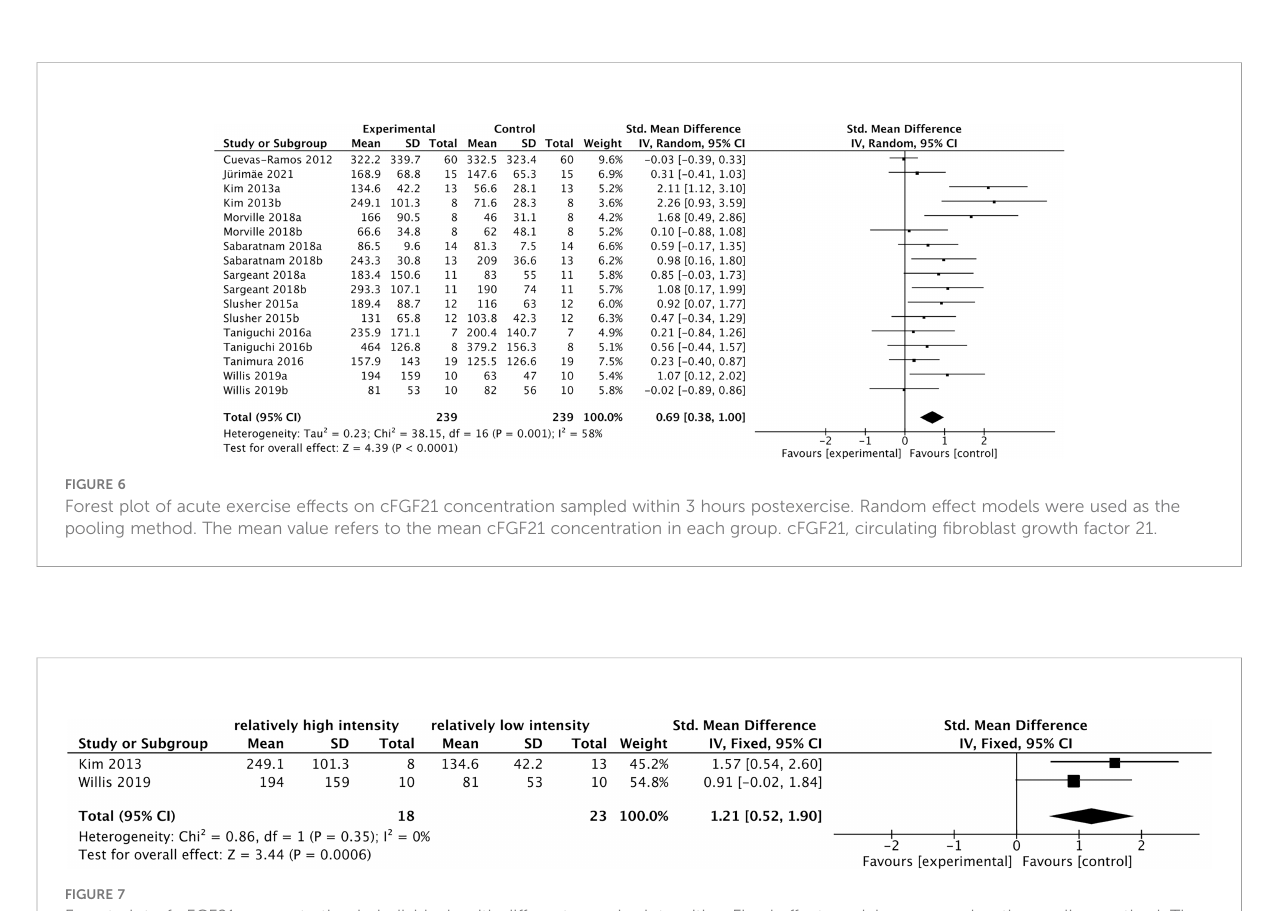
FIGURE 7 Forest plot of cFGF21 concentration in individuals with different exercise intensities. Fixed effect models were used as the pooling method. The mean value refers to the mean cFGF21 concentration in each group. cFGF21, circulating fi broblast growth factor